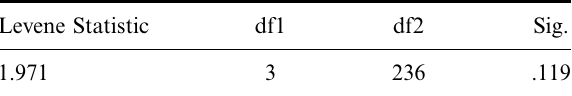
Table 5. Post-hoc comparisons with Tukey method